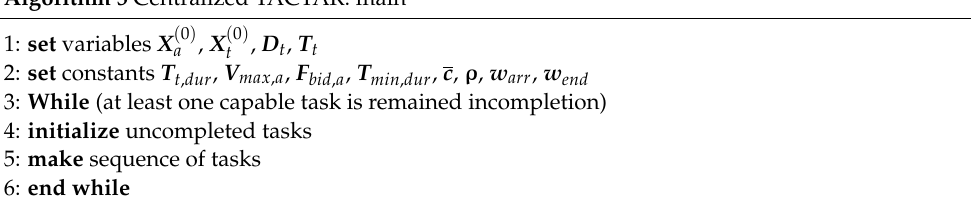
Algorithm 5 Centralized TACTAR: main